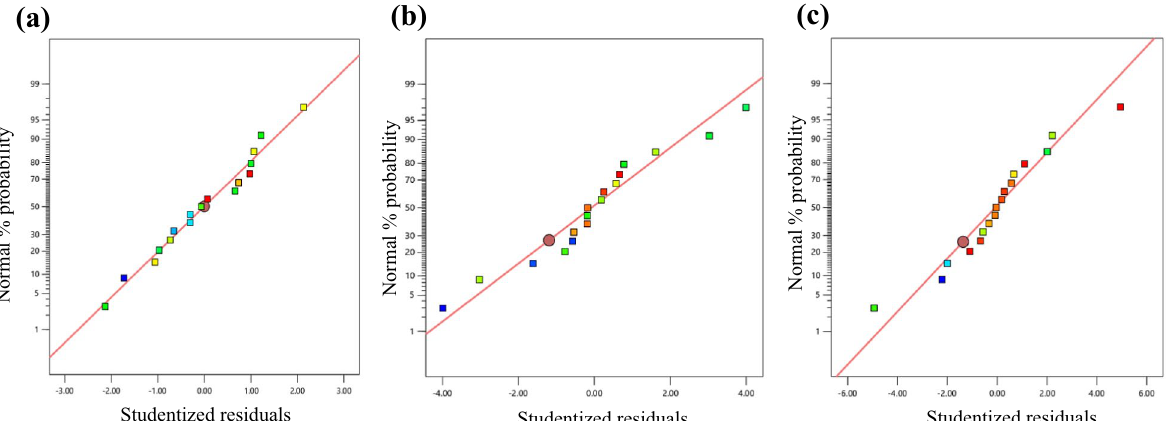
Fig. 1 Normal probability of studentized result for a particle size with R 2 of 0.76; b crystallinity with R 2 of 0.91; and c thermal decomposition with R 2 of 0.81 of the treated ultrasonic-homogenizer GAP waste